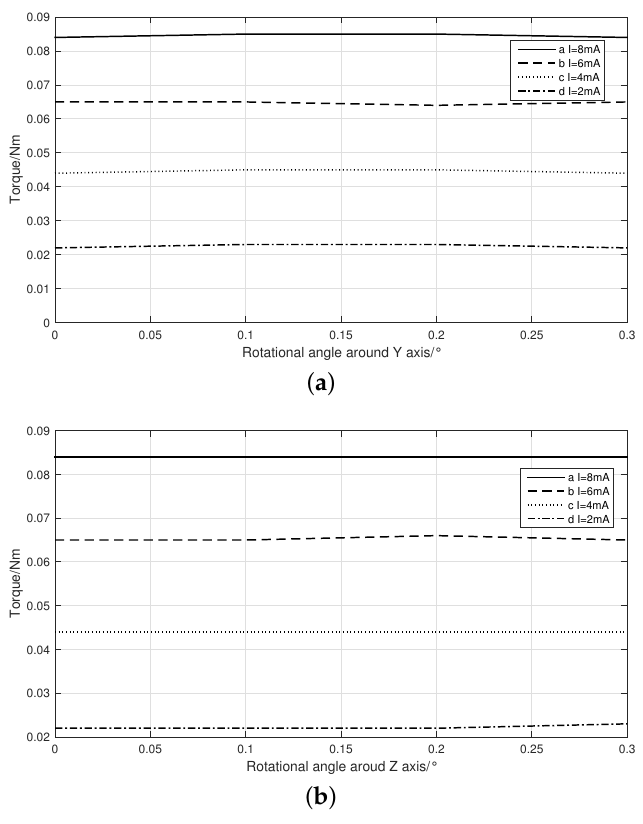
Figure 10. Influence of rotational assembly errors on torque generation. ( a ) Rotational assembly error about Y axis. ( b ) Rotational assembly error about Z axis.